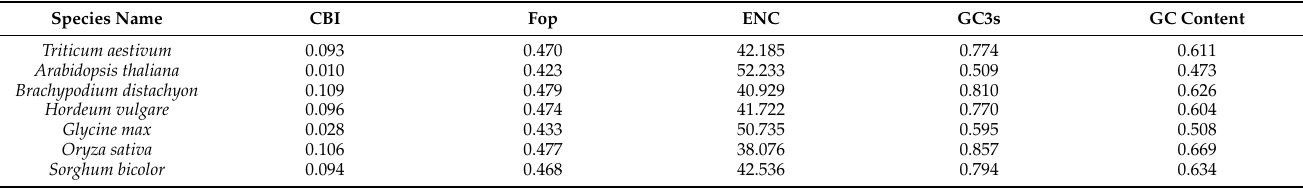
Table 4. Codon usage indicators of the cystatin family in seven different species. Abbreviations: CBI, codon bias index; Fop, frequency of optimal codons; ENC, effective number of codon; and GC3s, contents of G or C bases at the third position of the codons; and GC content, the contents of the G and C bases of the